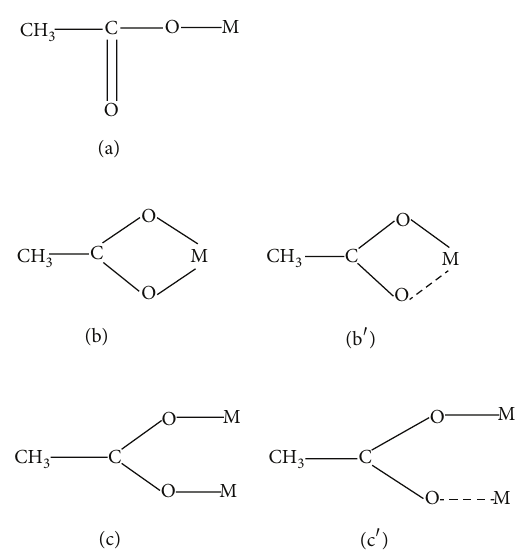
Figure 1: Coordination modes of acetate with metal, M = metal; (a) unidentate; (b) bidentate, symmetrical; (b’) bidentate, unsymmetri- cal; (c) bridging, symmetrical; (c’) bridging, unsymmetrical.